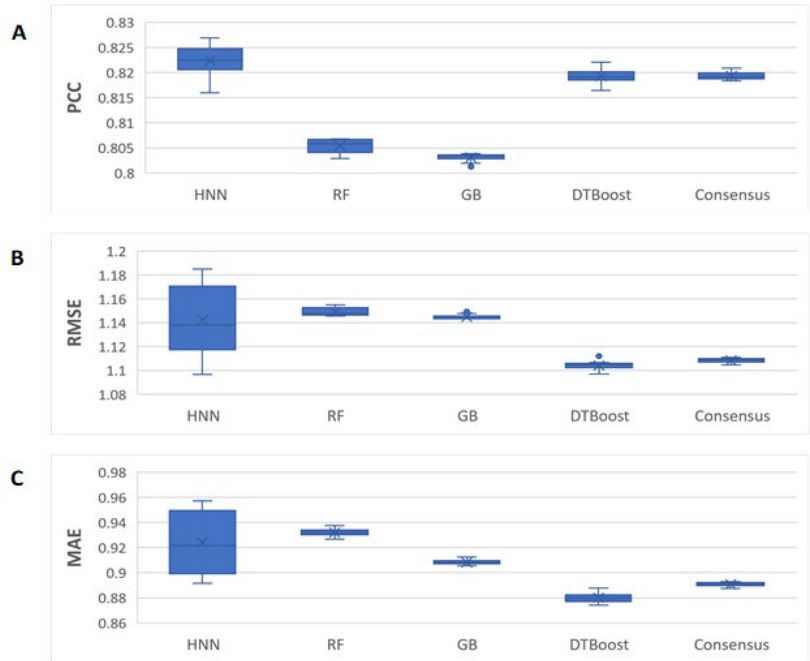
Figure 3. The HNN-denovo performance comparison to other models for the combined K d and K i binding data. ( A ) PCC, ( B ) RMSE, and ( C ) MAE of the binding affinity prediction by HNN, RF, GB, DT, and consensus methods.